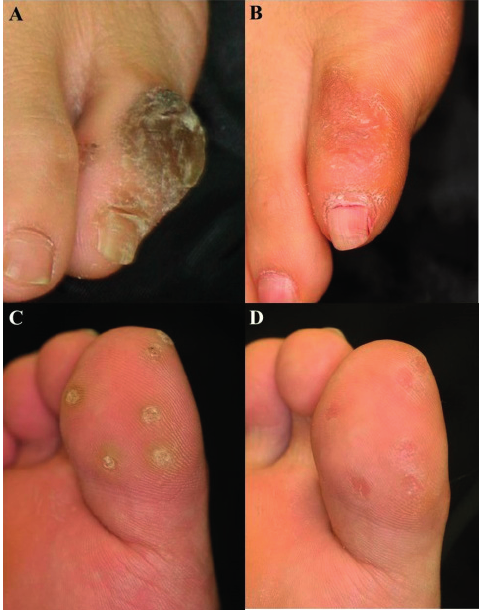
Figure 3. Representative photographs before and after ILI-PDT. Wart lesions on the foot at baseline ( A , C ) and 1 month after three sessions of ILI-PDT ( B , D ). Marked reduction of warts was shown on the great toe and little toe